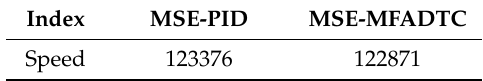
Table 1. Mean Square Error (MSE) indices without disturbance.